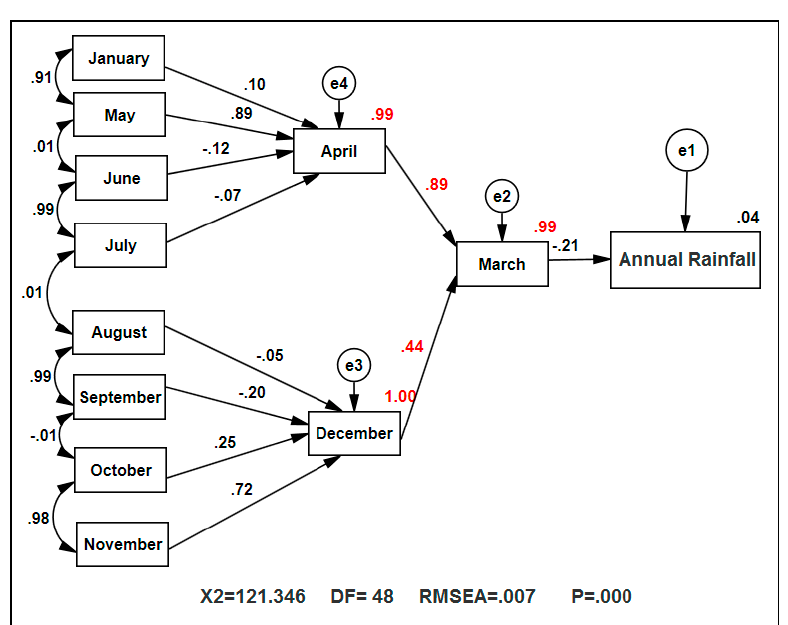
Figure 15. The effectiveness between the monthly temperature and annual rainfall (third model). Monthly effectiveness investigated on annual rainfall series. The effectiveness model shows that ten monthly temperature series (January, April, May, June, July, August, September, October, November and December) have an indirect effect on annual rainfall. March temperature has a direct effect (negative effect) on annual rainfall.